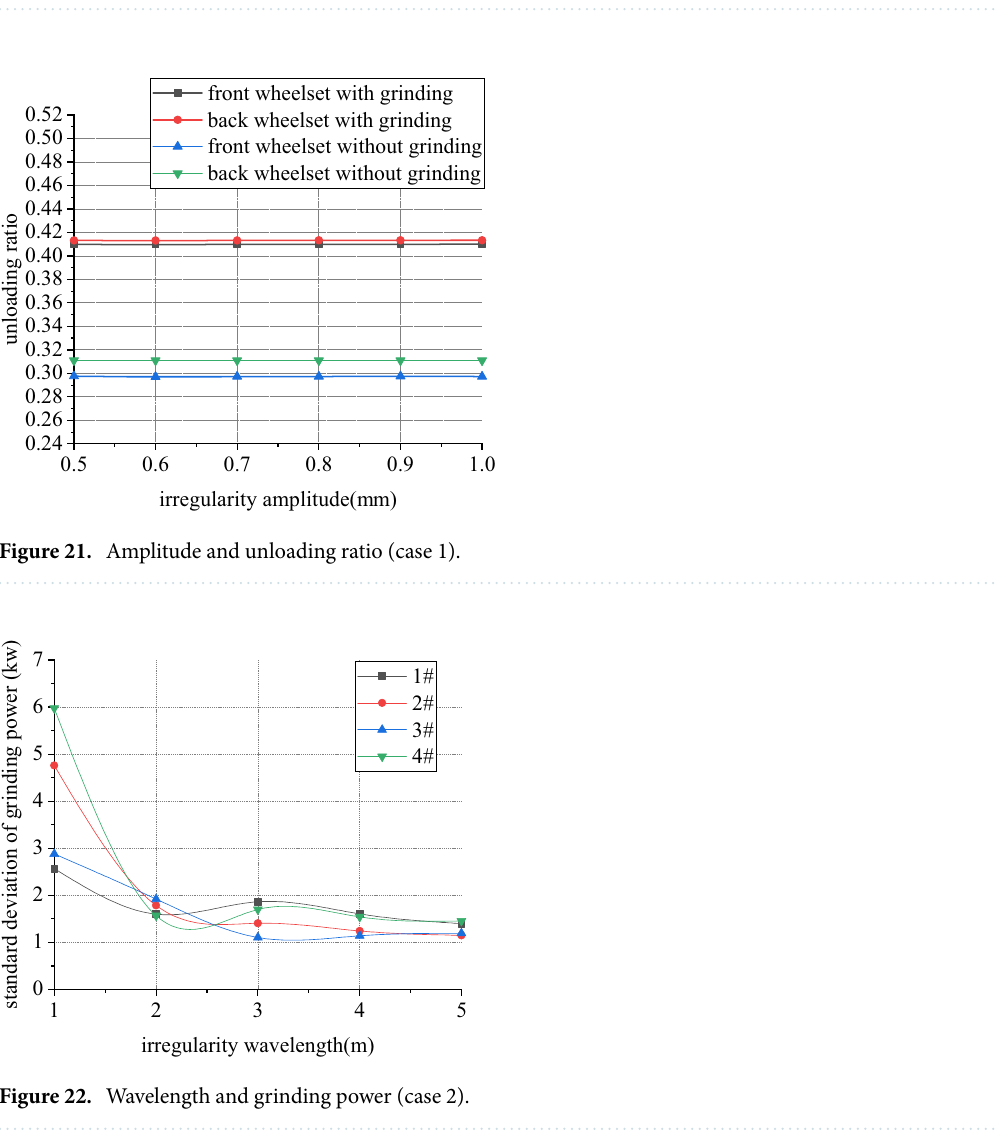
Figure 20. Amplitude and derailment coefficient (case 1).